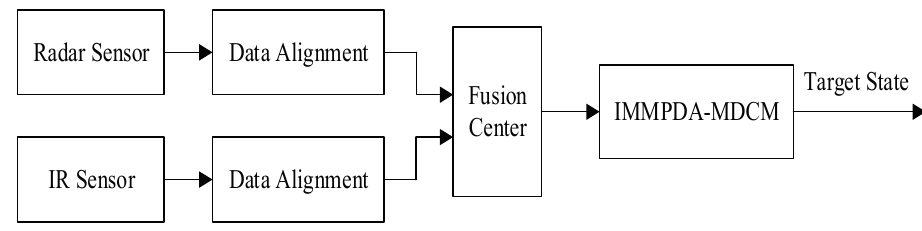
Figure 2. Centralized fusion tracking architecture with radar and IR